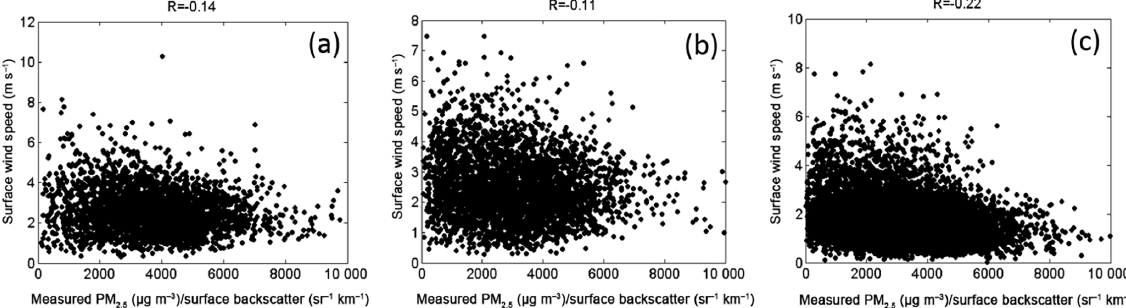
Figure 6. The relationship between surface wind speed and PM2.5/backscatter ratio for (a) daytime clear-sky cases, (b) daytime cloudy cases and (c) nighttime cases.